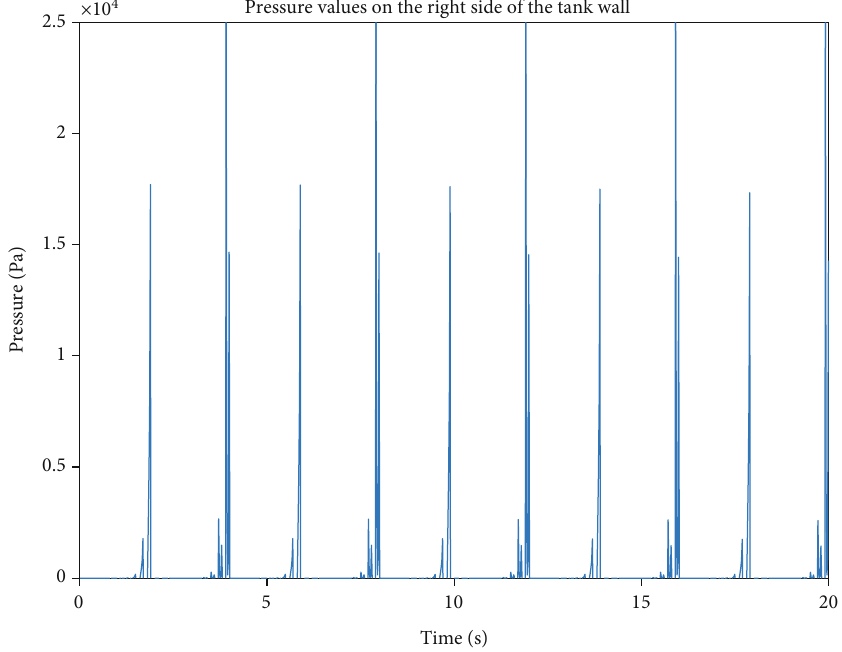
Figure 5: Variation in pressure acting on the tank wall for h = 0 : 38